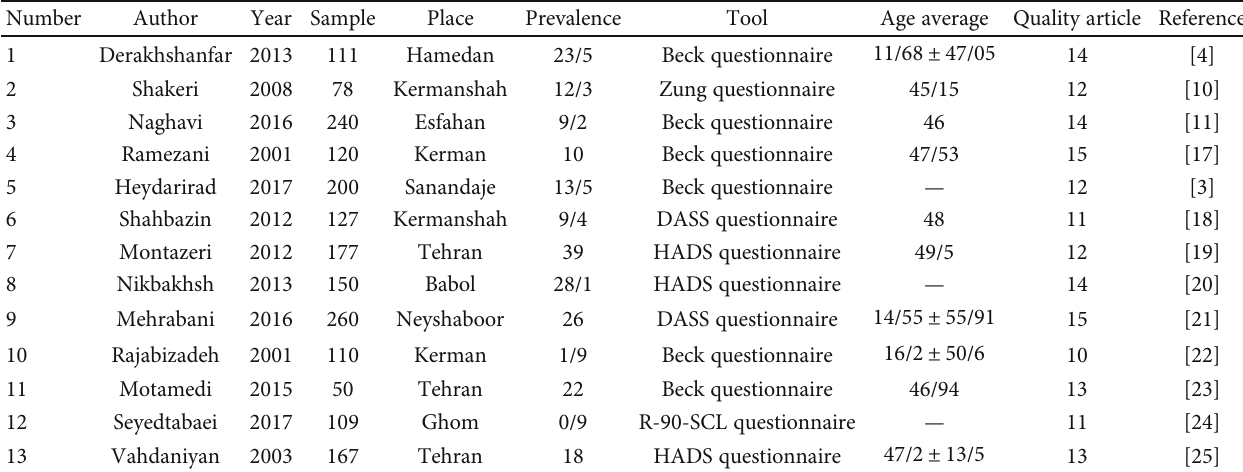
Table 2: Characteristics of the included studies.